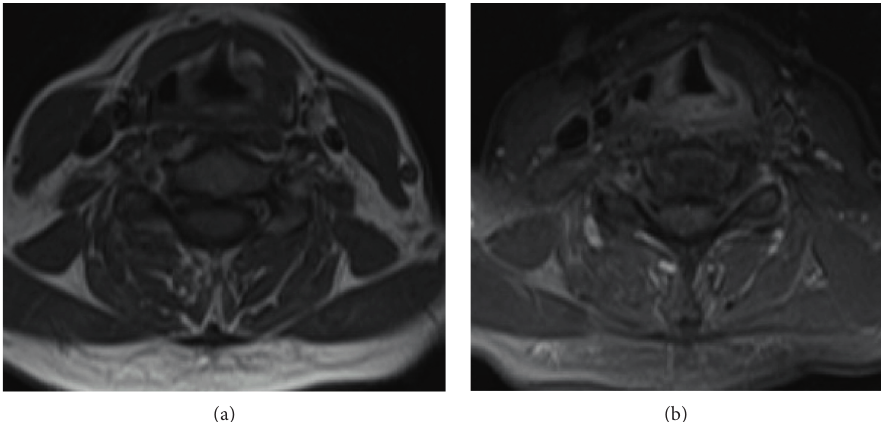
Figure 3: Axial MRI images demonstrating a nonenhancing lesion with fatty marrow changes arising from the left thyroid cartilage. (a) T1 without contrast. (b) T1 fat saturation with contrast.